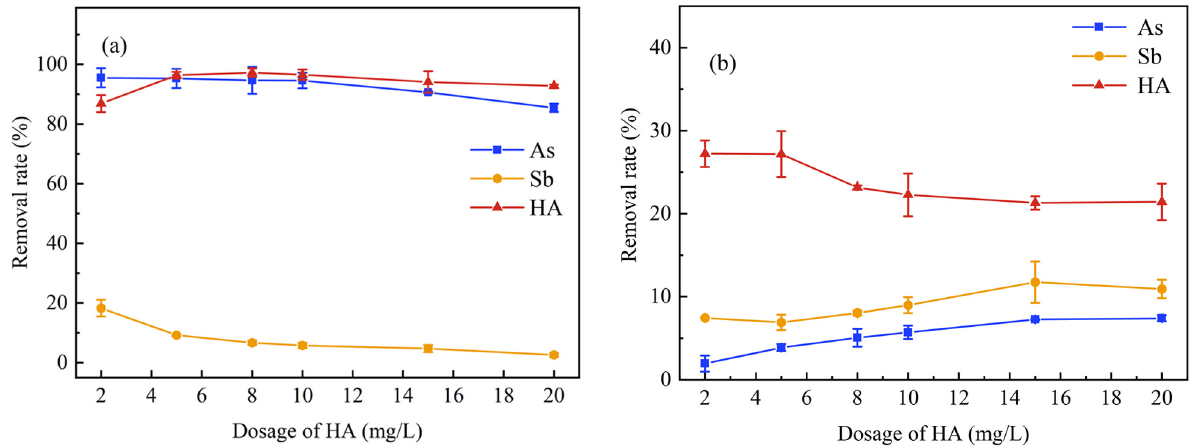
Figure 3. Effect of HA dosing on the simultaneous removal of As and Sb. ( a ) K 2 FeO 4 (Fe of 8.48 mg/L) treatment; ( b ) no K 2 FeO 4 .